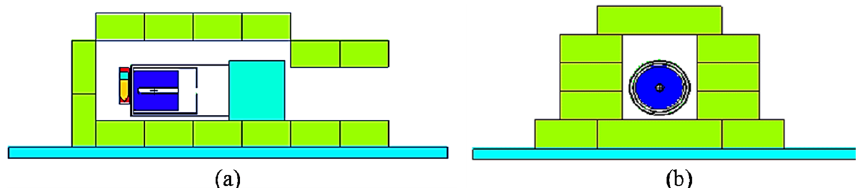
Figure 2. In vivo neutron irradiation assembly along with the components (moderator, reflector, biological shielding) was modeled in MCNP (XY view of the assembly shown here) (created with MCNP 6.1 https:// laws. lanl. gov/ vhosts/ mcnp. lanl. gov/ index. shtml).